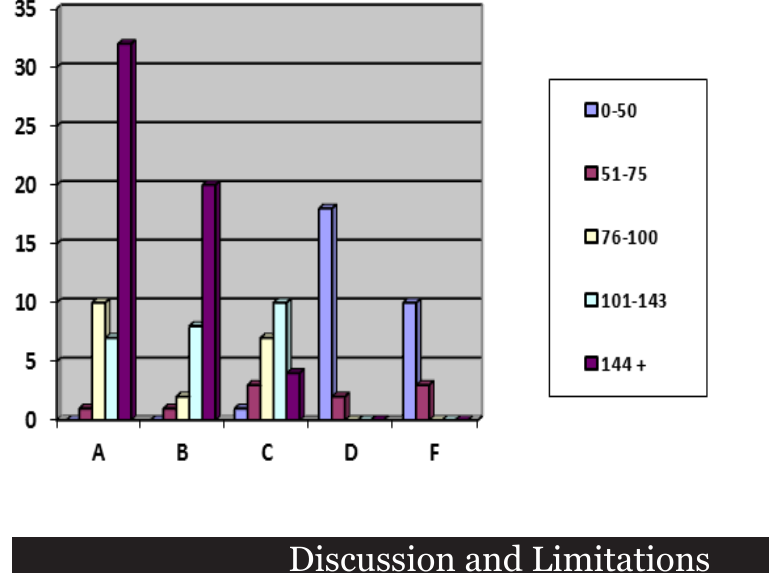
Comparison of Letter Grade Frequency Compared to Hours Spent Reviewing